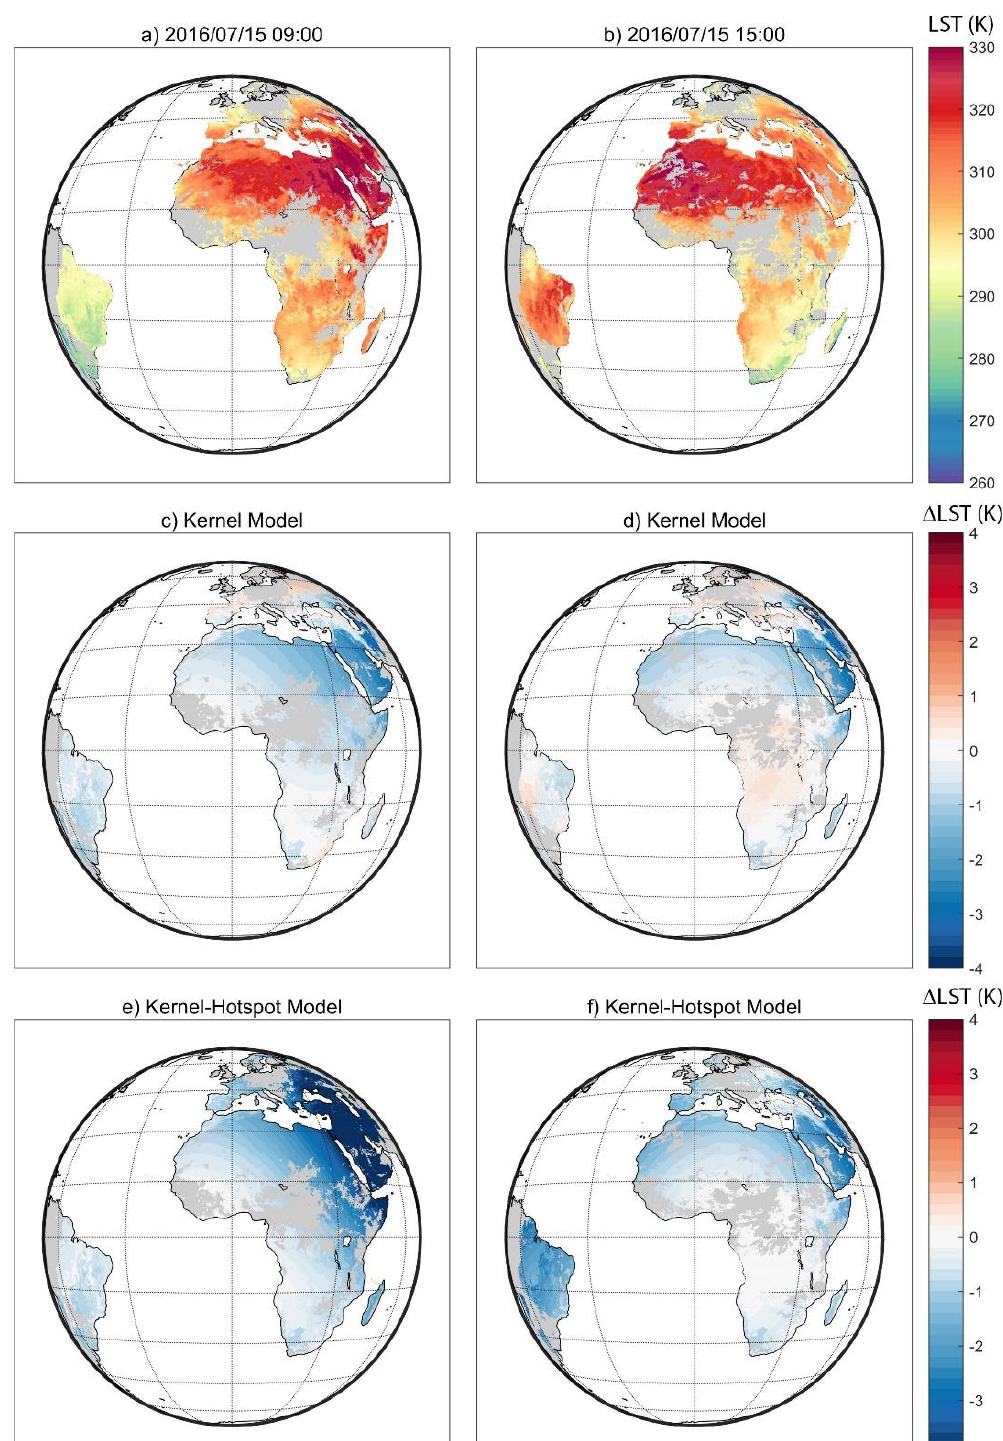
Figure 10. As in Figure 9 but at 09:00 UTC ( a , c , e ) and 15:00 UTC ( b , d , f ).